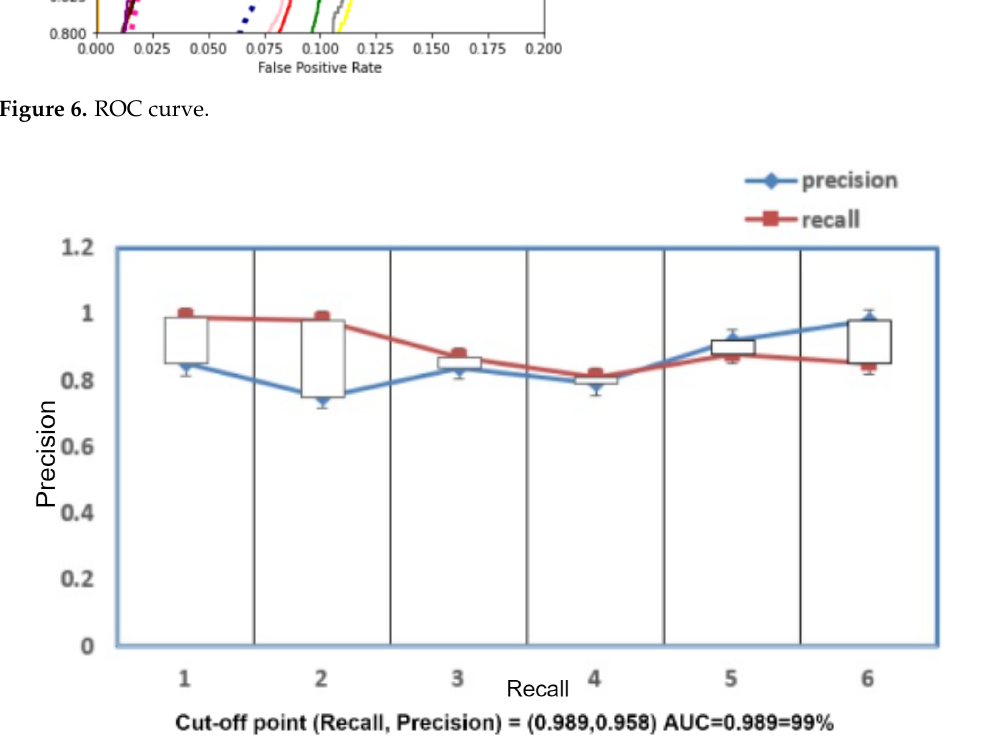
Figure 7. Precision and Recall.